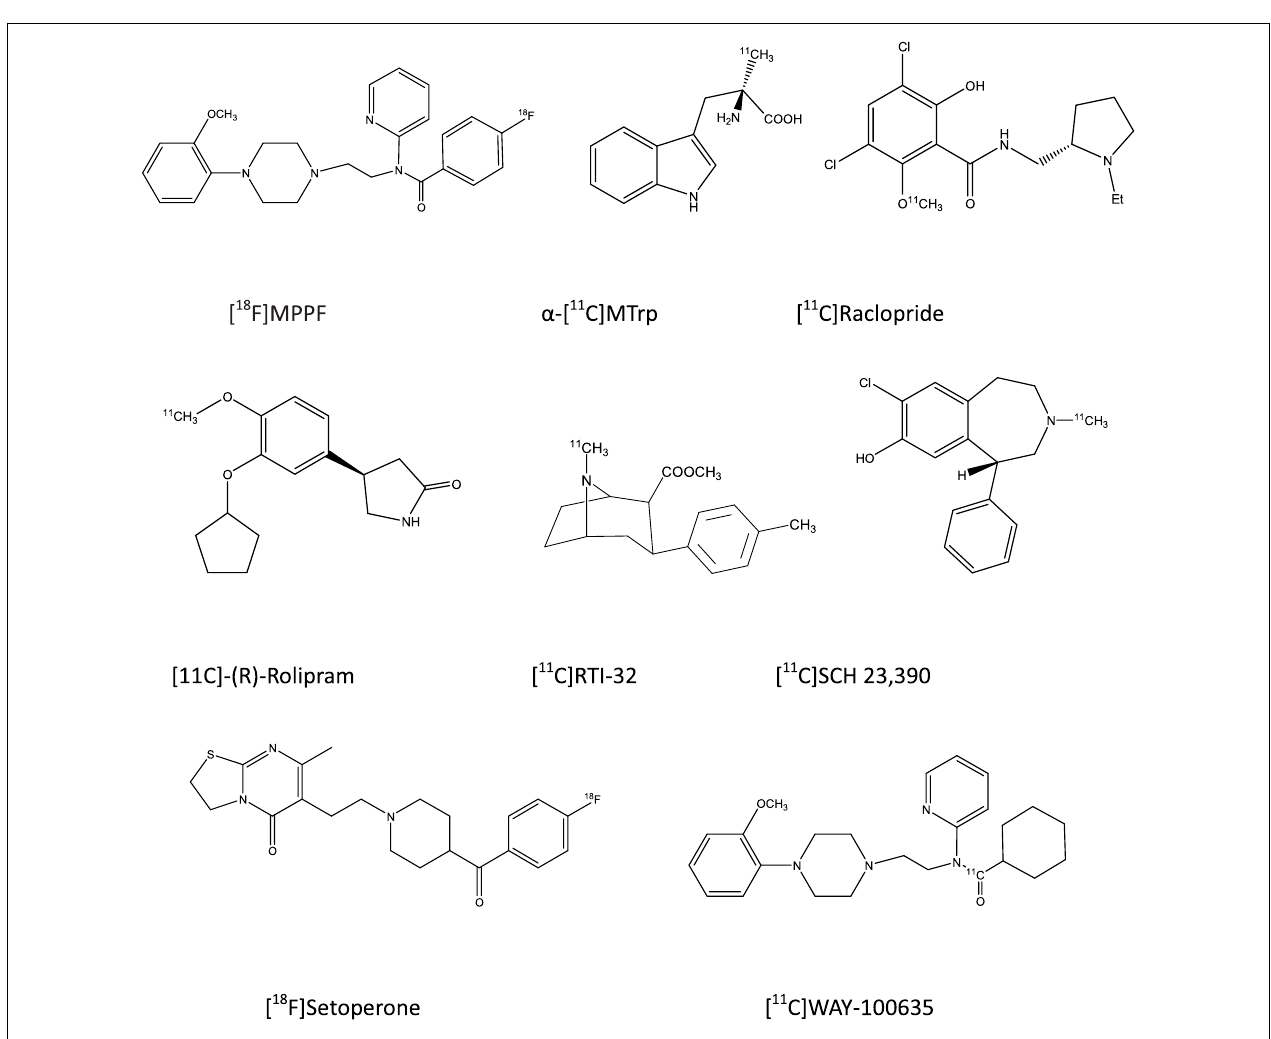
FIGURE 1 | Structural drawings of PET radioligands cited in the present review on depressive